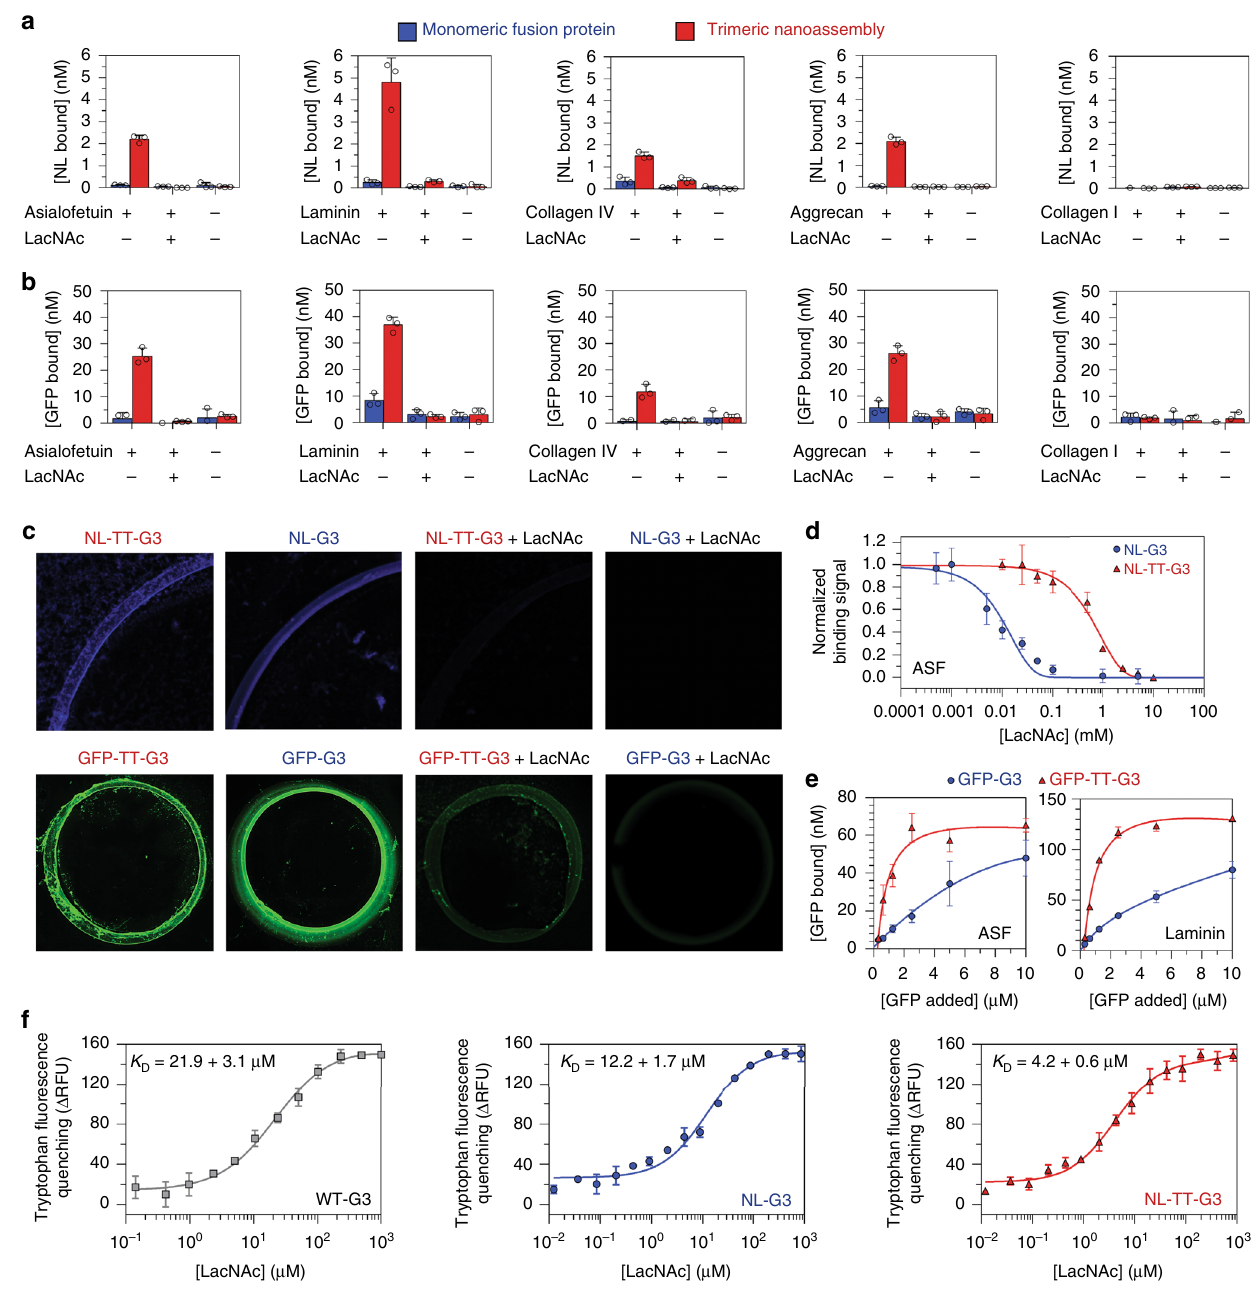
Fig. 3 Carbohydrate-binding properties of monomeric G3 fusion proteins and trimeric nanoassemblies. a , b NL-G3, NL-TT-G3, GFP-G3, and GFP-TT-G3 binding to asialofetuin (ASF), laminin, collagen IV, aggrecan, and collagen I (negative control) adsorbed onto plastic. c Micrographs taken of NL luminescence or GFP fl uorescence localized to a laminin coffee ring adsorbed onto glass. Fusion proteins were mixed with soluble LacNAc to demonstrate inhibition of binding to adsorbed glycoconjugates for a – c . d Competitive inhibition of binding of NL-G3 and NL-TT-G3 to adsorbed ASF by soluble LacNAc. e Saturation binding of GFP-G3 and GFP-TT-G3 to adsorbed ASF and laminin. f Tryptophan fl uorescence quenching of wild-type G3 (WT-G3), NL-G3, and NL-TT-G3 via binding to soluble LacNAc. N = 3, mean ± s.d. for a , b , d – f . Data points at or above baseline signal are shown as open circles in a , b . Data for WT-G3 appear as gray squares/traces, for monomeric G3 fusion proteins as blue bars/circles/traces, and trimeric nanoassemblies as red bars/triangles/